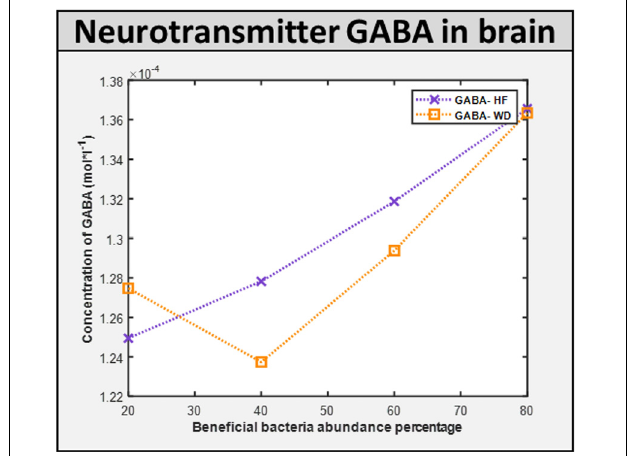
FIGURE 9 | ROS induced level of neurotransmitter in the brain. GABA concentration in the brain with different diet HF and WD and increased level of probiotic intervention in the corresponding gut model.